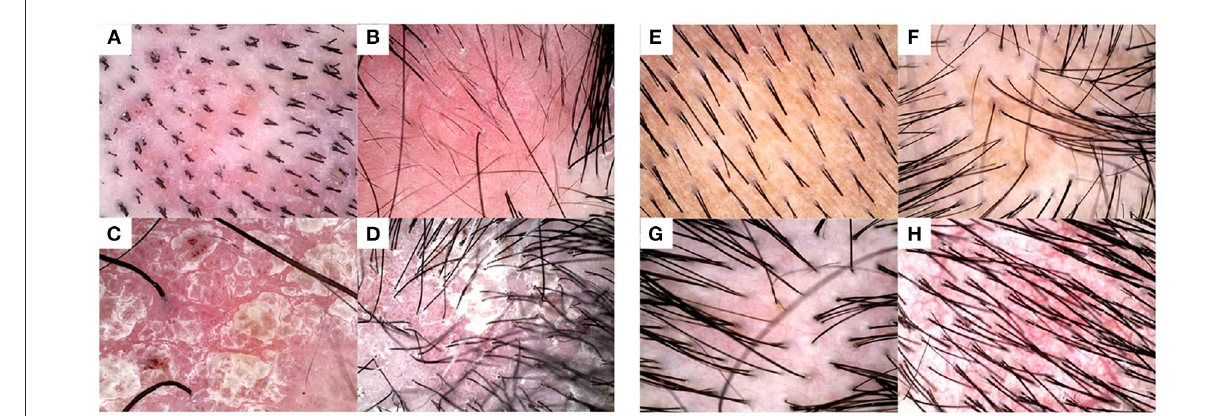
FIGURE1 Examples of typical dermoscopic images. Typical images from (A–D) psoriasis lesions, wherein annular and hairpin blood vessels that have high specificity for the diagnosis can be seen under dermoscopy, and (E–H) seborrheic dermatitis lesions, wherein branching and atypical vessels show distinct unstructured white areas and honeycombed pigmentation networks.